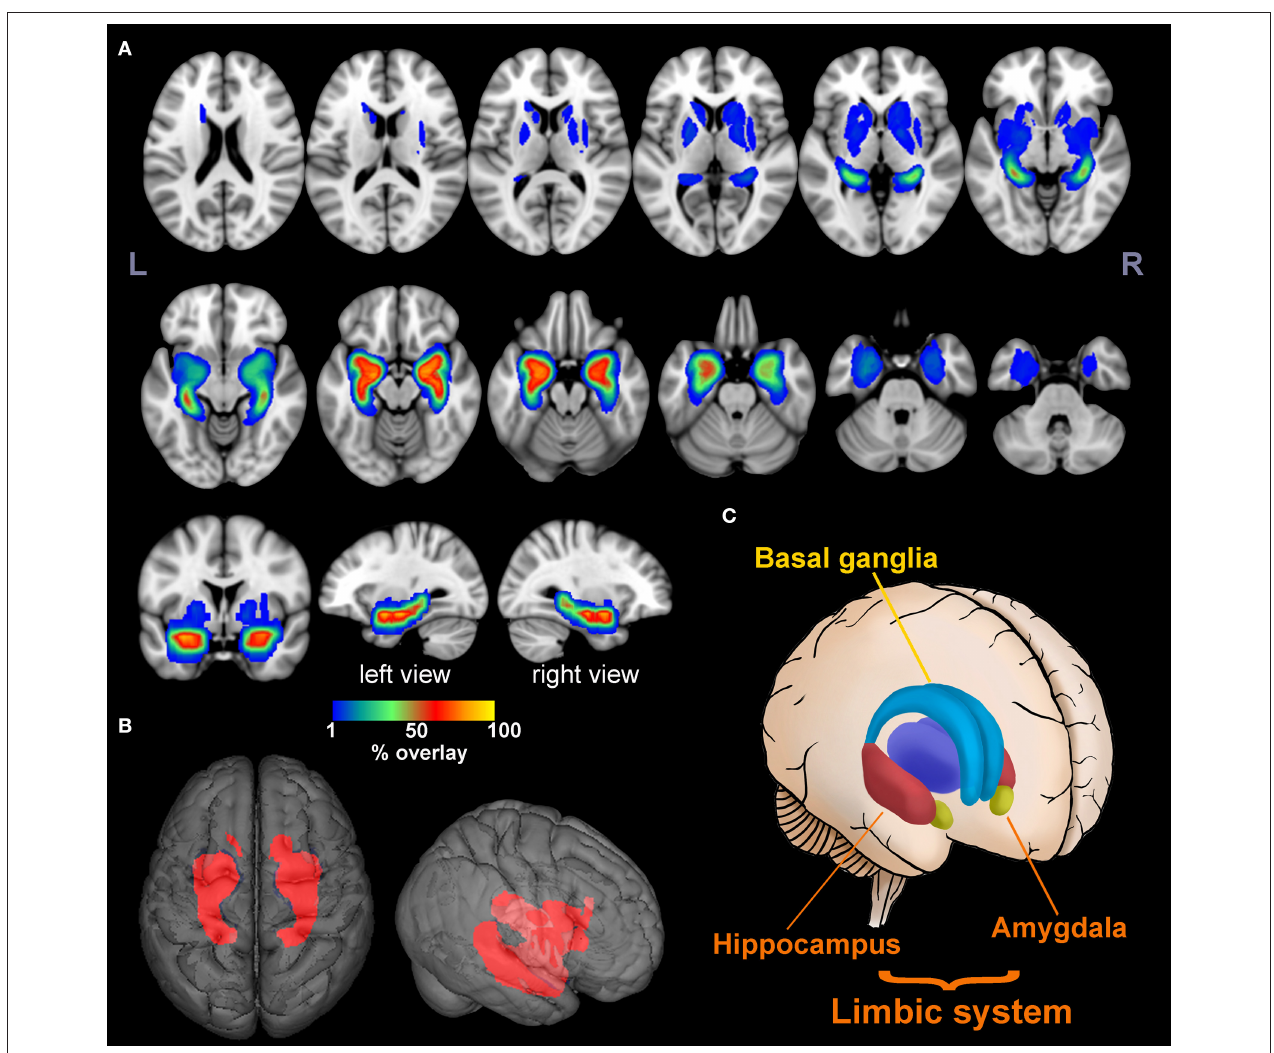
FIGURE 2 | Lesion overlap map. The multislice view (A) and 3D view (B) of the lesion overlap map for 57 MR-positive patients. The color bar indicates the percentage of lesion overlay. The brain regions involved mainly included the limbic system and basal ganglia as illustrated in (C) . More than 50% of the lesions overlapped in the hippocampus and amygdala [hot colors in (A)